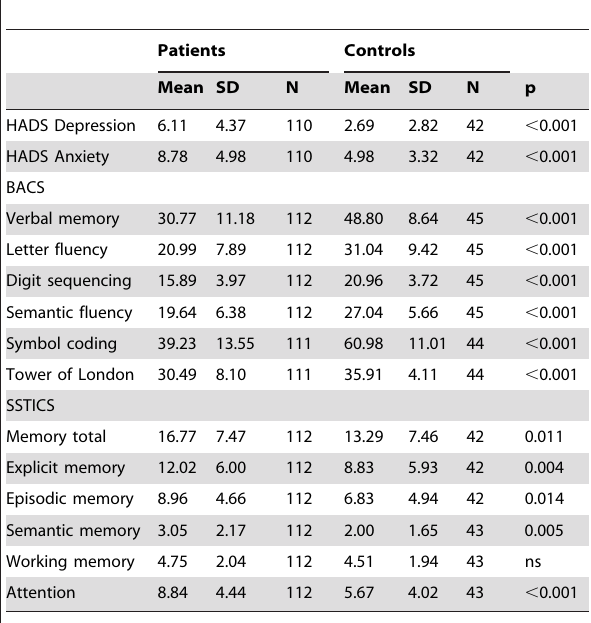
Table 1. Between group differences in depression, anxiety, objective cognition and subjective